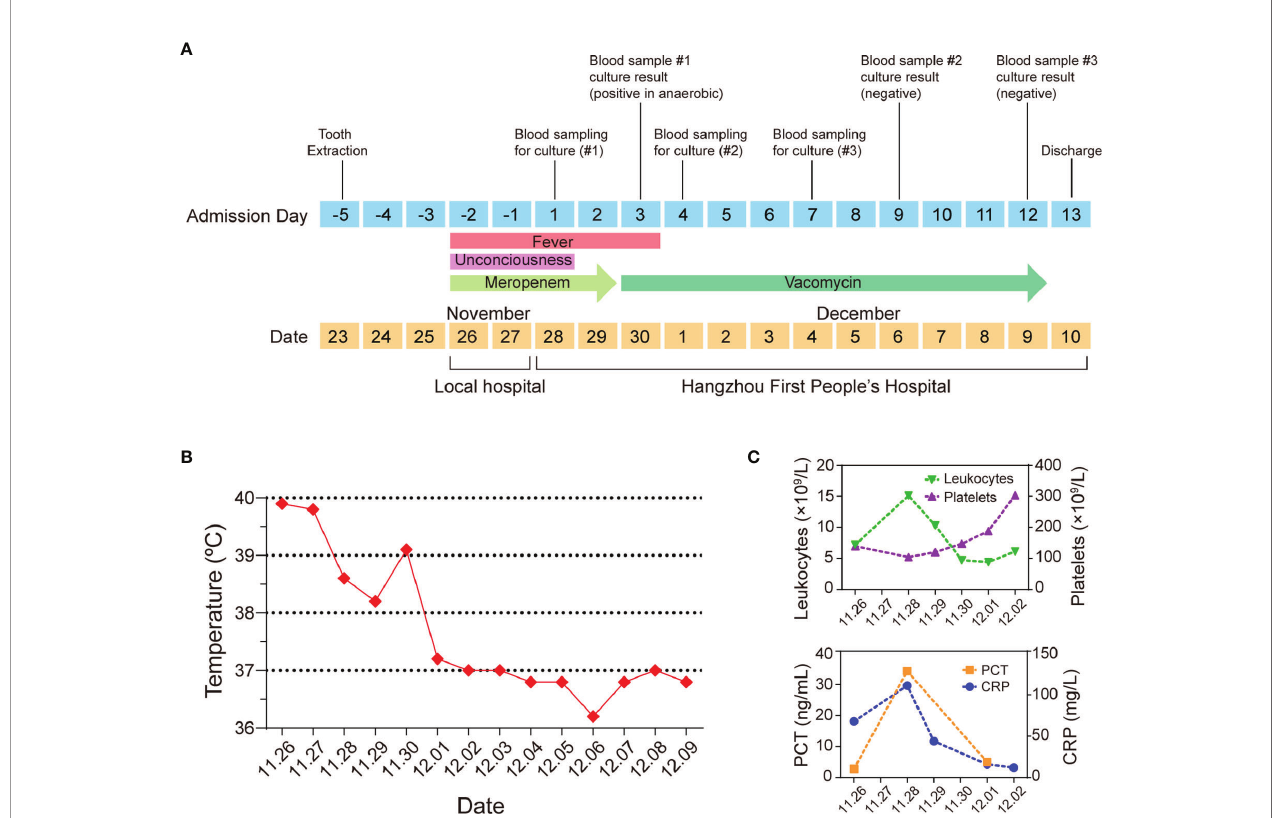
FIGURE 1 | An atypical case of a 63-year-old man with C. dif fi cile septicemia in Zhejiang, China. (A) Timeline of the main events of the case. (B) Clinical evolution of fever. (C) Clinical data of leukocytes, platelets, PCT, and